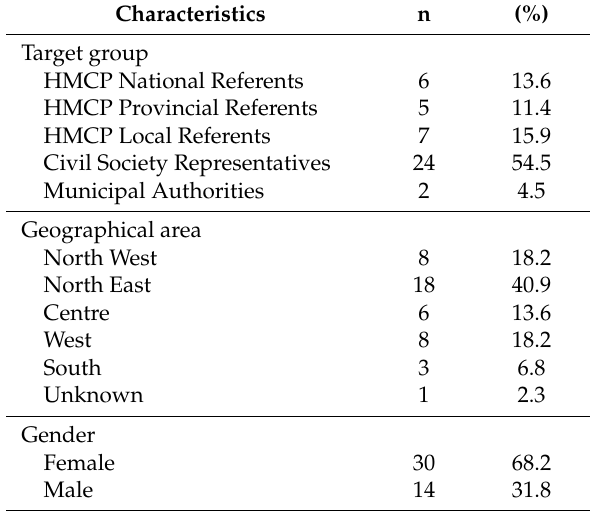
Table 1. Characteristics of the participants in qualitative interviews (n =